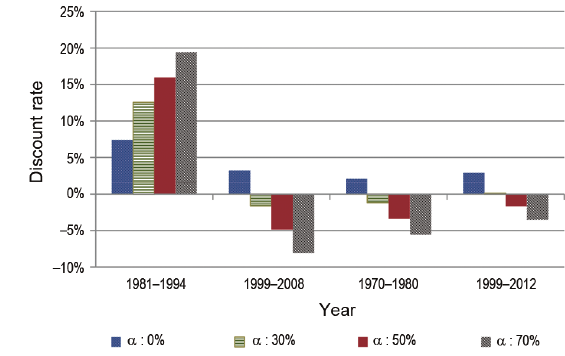
Fig. 4. The average equivalent discount rates in different time periods